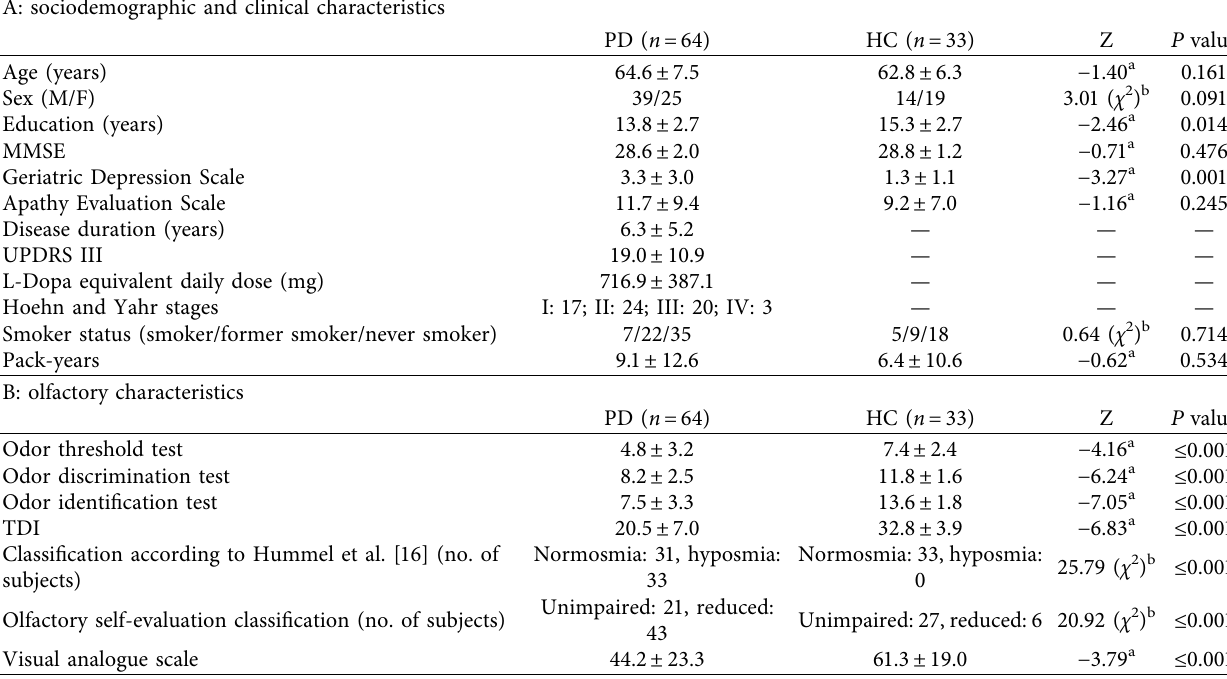
Table 1: Sociodemographic, clinical, and olfactory characteristics of the study sample. A: sociodemographic and clinical characteristics